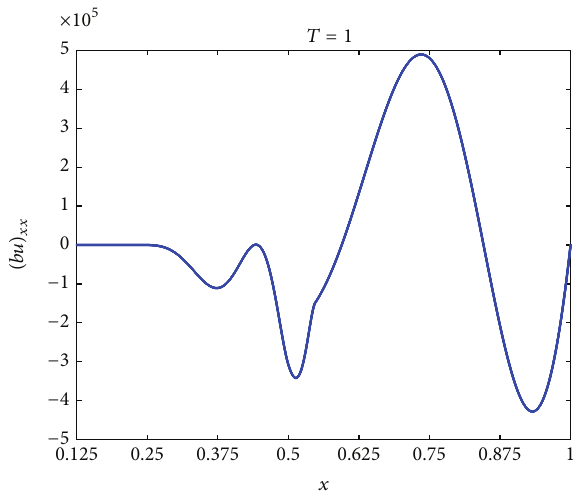
Figure 2: Test Problem 2. Approximated second derivative of 𝑏𝑢 .